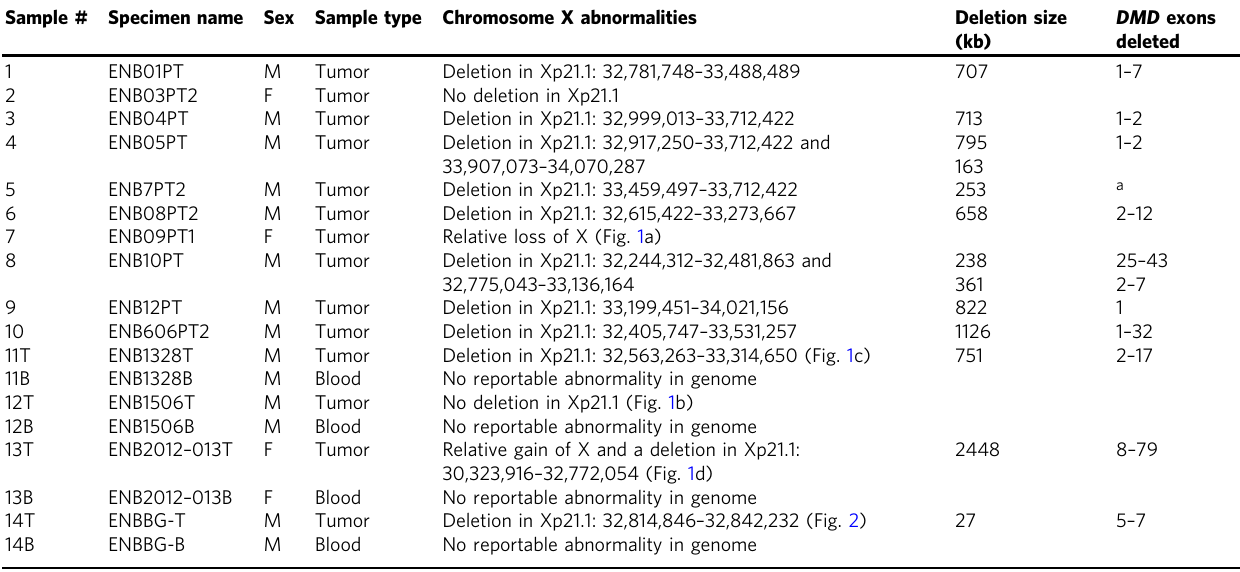
Table 1 SNP array evaluation of chromosome X in ONB Sample # Specimen name Sex Sample type Chromosome X